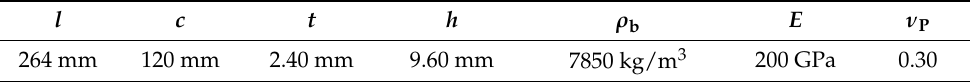
Table 1. Blade geometrical and material parameters for the FEM case